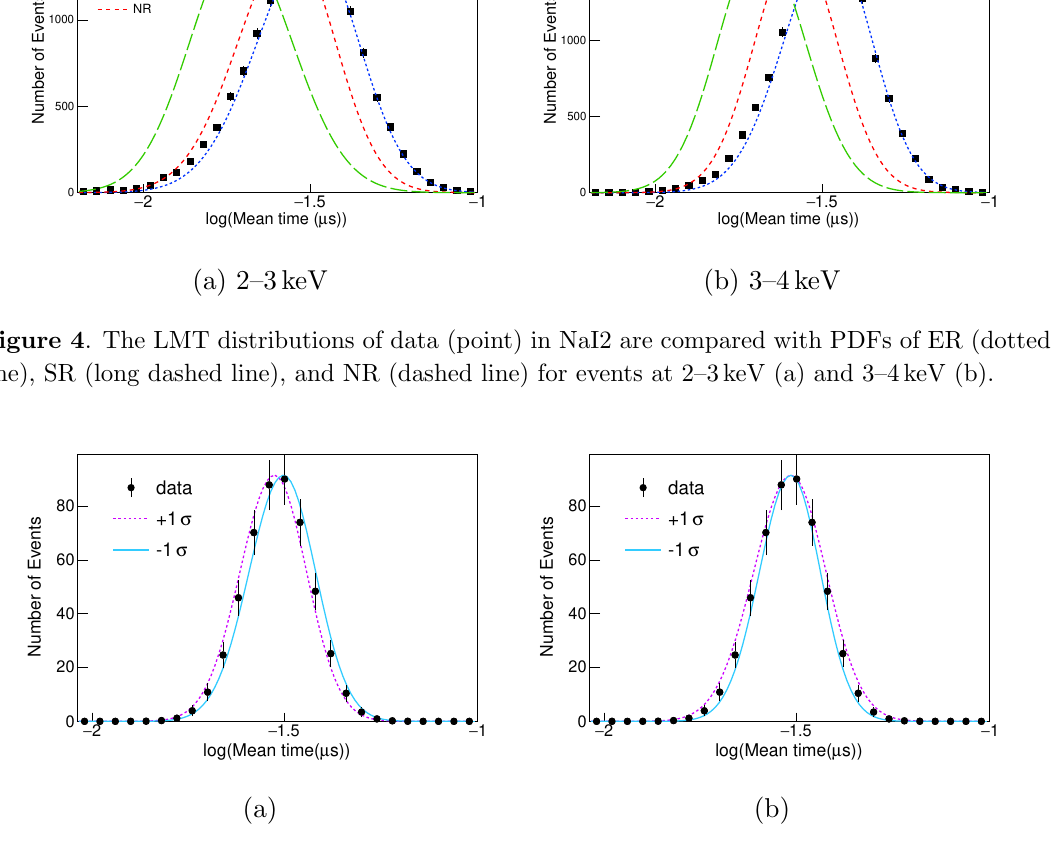
Figure 5 . The distributions shifted by the mean (a) and RMS (b) uncertainties for NR events in the 7 to 8 keV energy region, where the largest shape changes